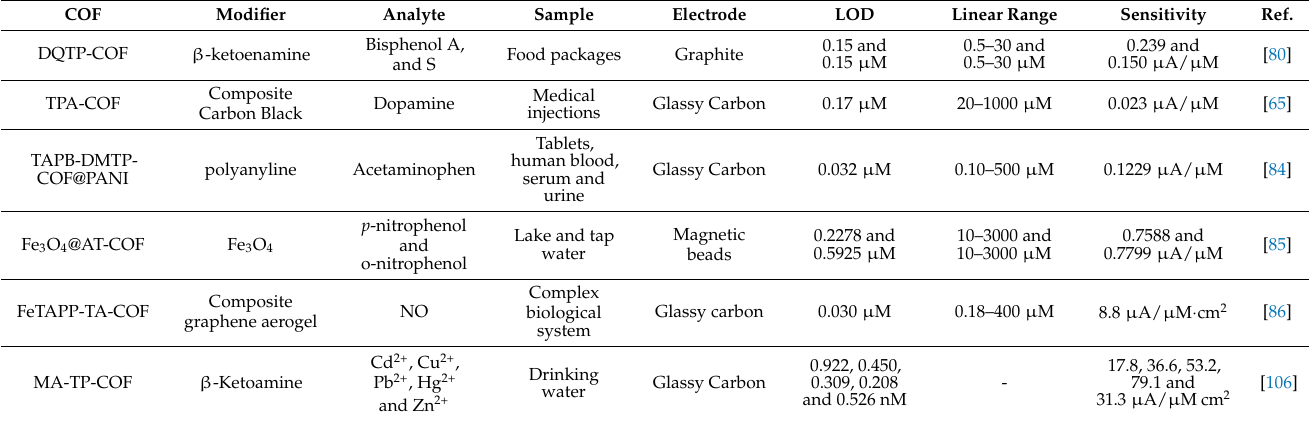
Table 1. Examples of COFs application in different